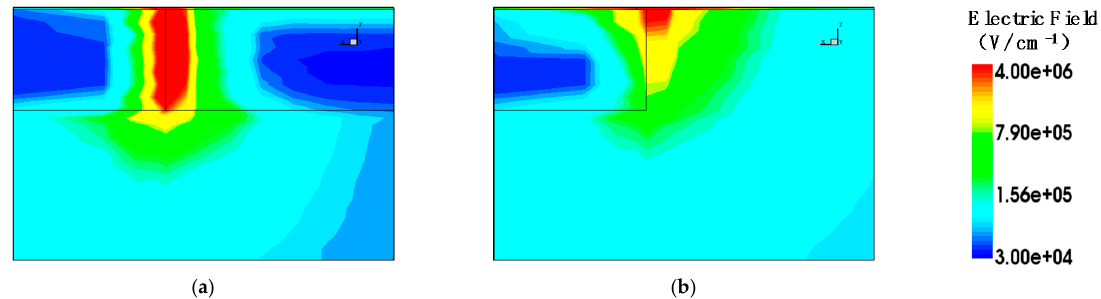
Figure 5 . Distribution of electric field intensity at the source and channel of ( a ) PNN TFET and ( b ) Conventional TFET at 90 ns under 1 mA/ μ m TLP current.